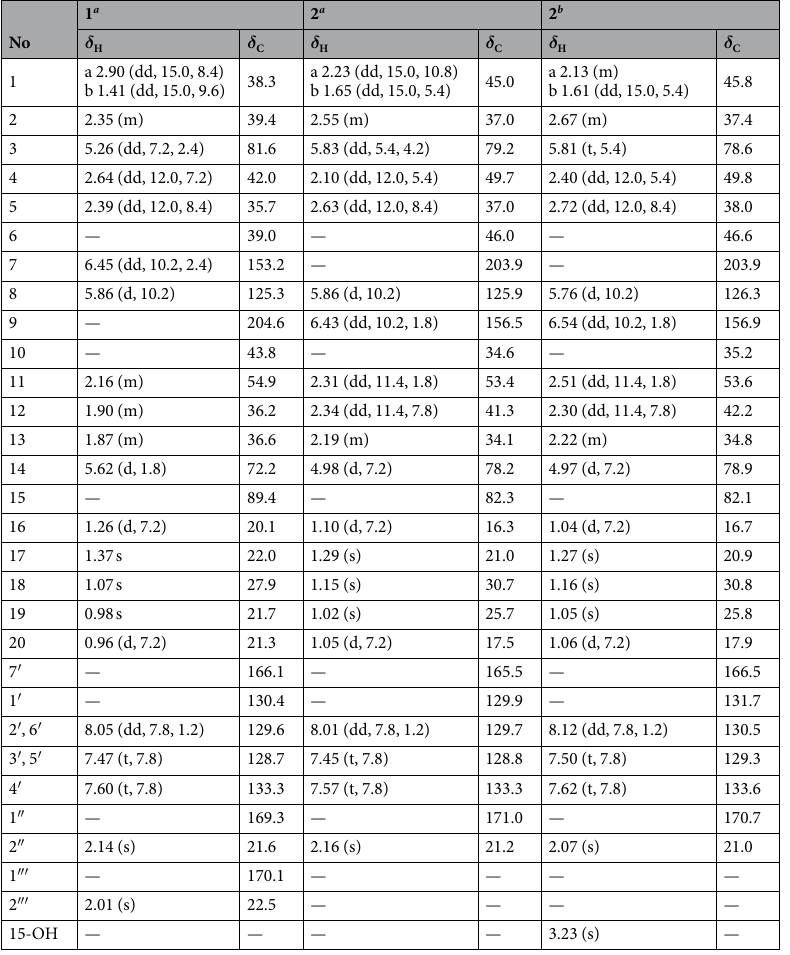
Table 1. 1 H NMR (600 MHz) and 13 C NMR (150 MHz) Data of Heliosterpenoid A and B ( δ in ppm, and J